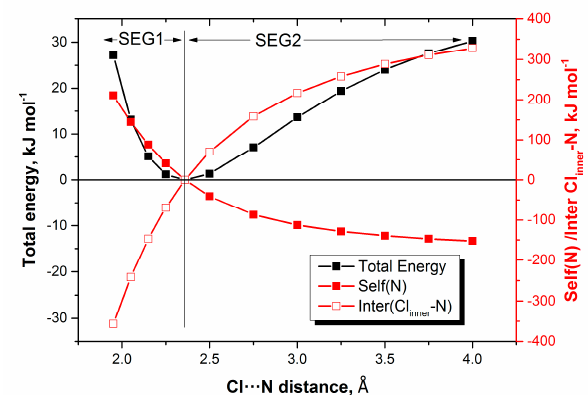
Figure 3. Energy profiles (total, intra-atomic energy of N 3 , and interatomic Cl inner –N 3 ) of H 3 N:ClF as a function of the distance between the “inner contact atoms” Cl inner and N 3 .